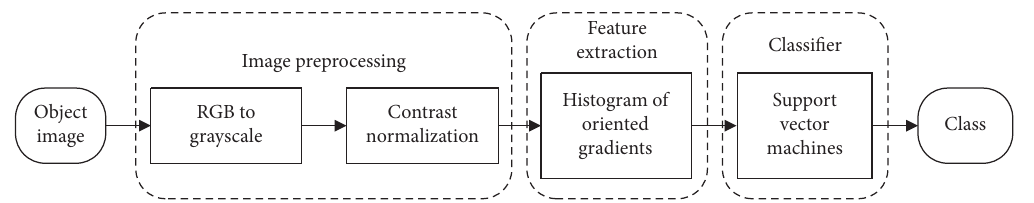
Figure 7: Vision pipeline of the passenger recognition system based on the HOG descriptor and on the SVM classifier. The conversion combined with the normalization is aimed at reducing of time complexity of the system.